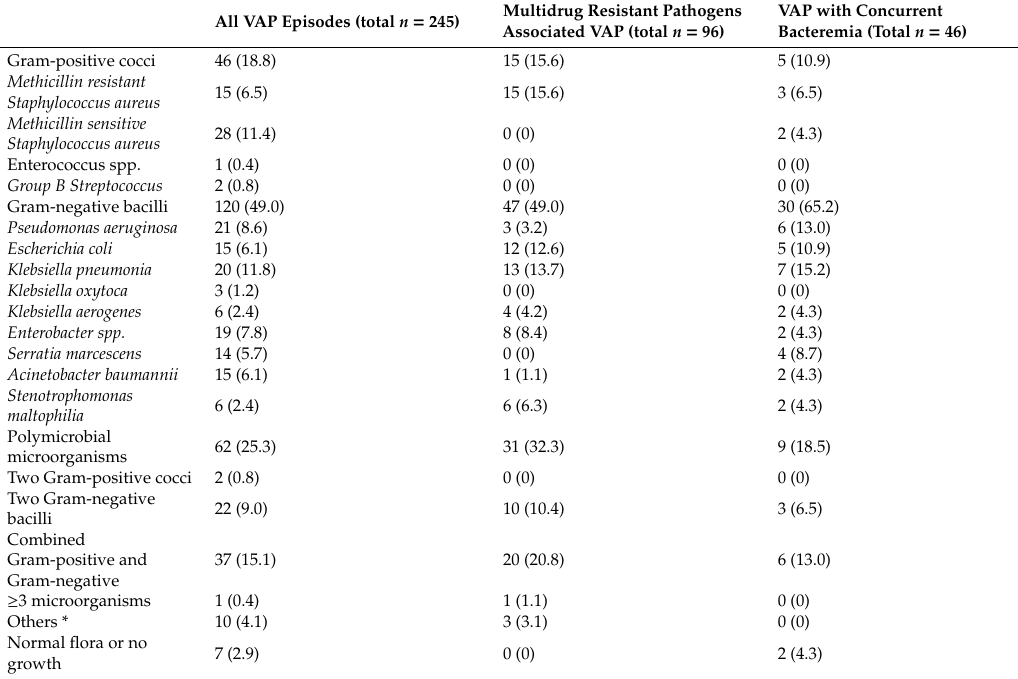
Table 1. Pathogen distribution of neonatal ventilator-associated pneumonia (VAP) in the neonatal intensive care unit (NICU) of Chang Gung Memorial Hospital (CGMH), October 2017 to March 2020. All VAP Episodes (total n =